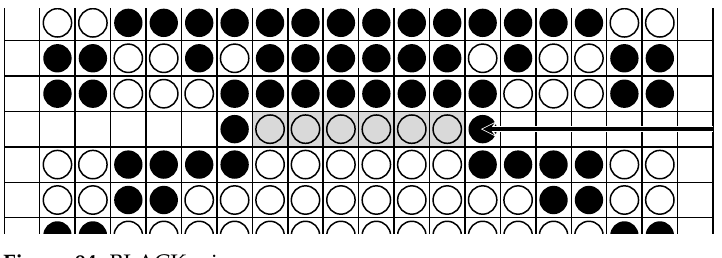
Figure 94. BLACK wins.